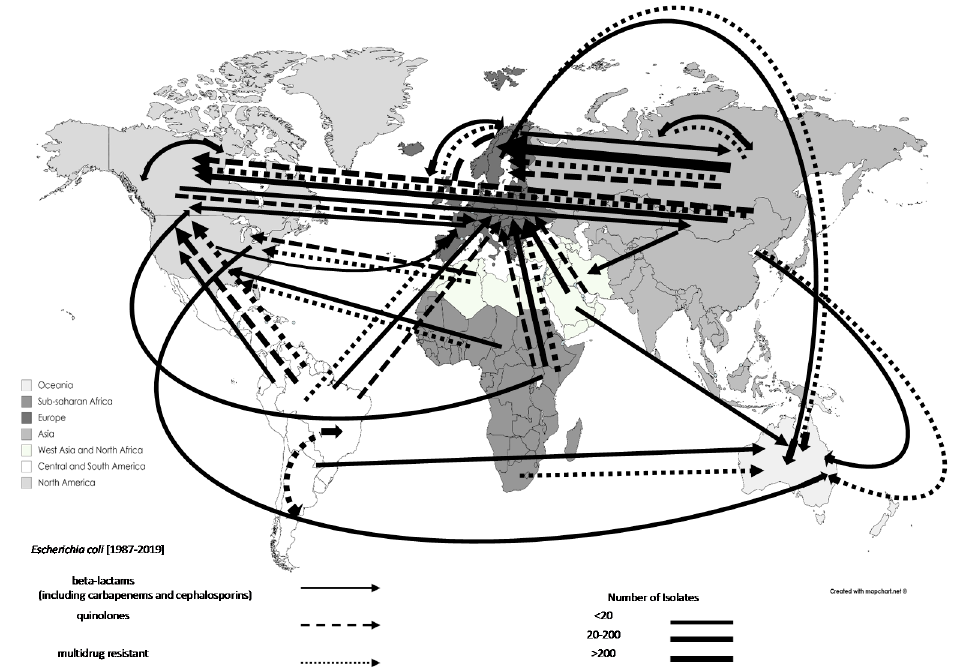
Figure 5. Travel-related antimicrobial resistant Escherichia coli transmission, 1987–2019: data are shown by arrows repre- senting antimicrobial resistant isolate movements, where the arrowhead represents the destination and the base of the arrow represents the source. Thus, double-headed arrows represent movements between the same regions. Different regions are represented by different shades.